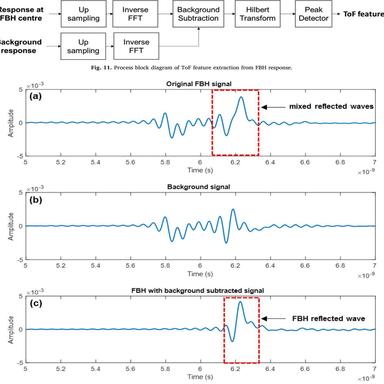
Time-domain signal at H1 centre: (a) original (b) background (c) background subtracted.